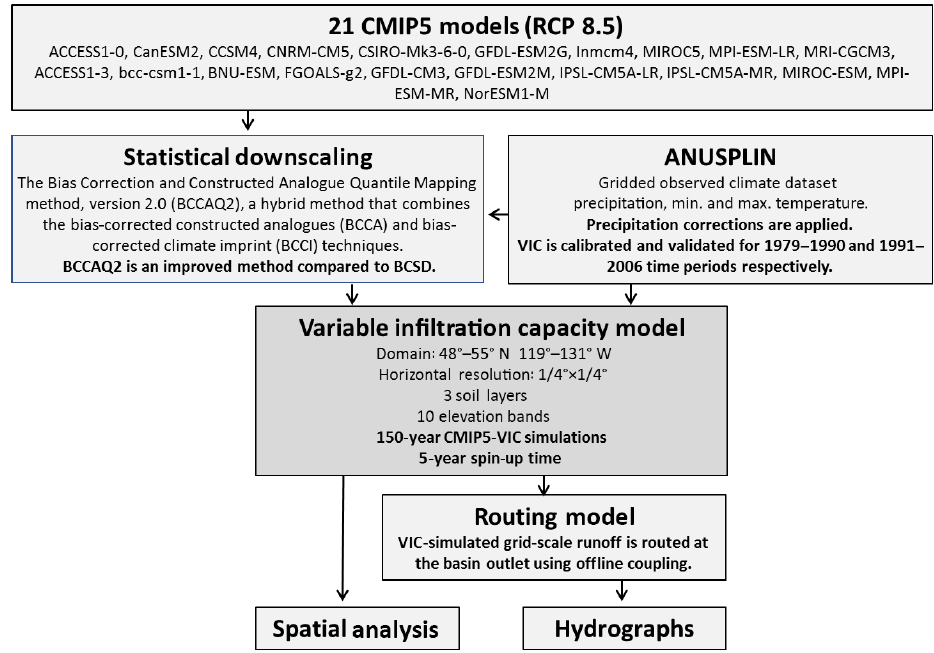
Figure 2. Block diagram of the VIC model experimental setup and analysis. Table 2. Decomposition of the key drivers affecting cold season runoff changes in the 2080s. Contributions are in %, estimated using the multivariate linear regression (MLR, described in Sect. 2.4.2) model using monthly time series from 21 CMIP5 simulations. R 2 provides the variance explained by all three variables. The grid-cell-averaged contributions are estimated only for statistically significant values at p < 0 . 05. Change in each variable is normalized by the total runoff change to estimate its contribution. The contributions listed in last three columns do not necessarily sum to exactly 100% due to rounding off and/or masking of insignificant grid cells before taking area averages. To facilitate comparison with MLR, runoff changes for the VIC model are estimated using specific grid cells within each region. Runoff change Contribution to runoff Region 2080s (%) change (%) R 2 VIC MLR Rainfall Snowfall Mean air temperature Coast Mountains 121 146 0.70 61 8 32 Interior Plateau 114 140 0.42 44 4 46 Rocky Mountains 79 117 0.45 44 6 50 Fraser River Basin 107 133 0.45 47 8